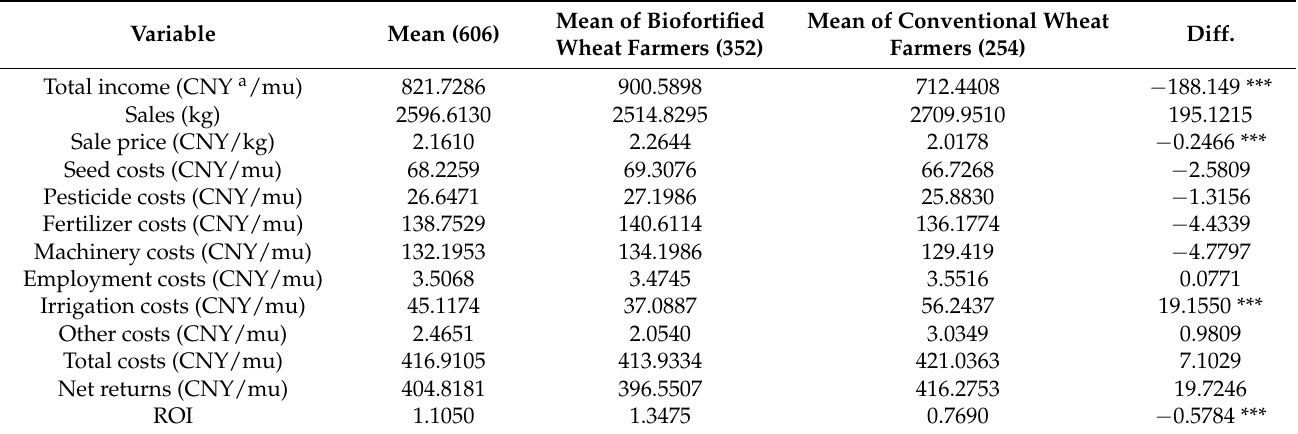
Table 3. Mean differences in production costs and profit between biofortified wheat farmers and conventional wheat